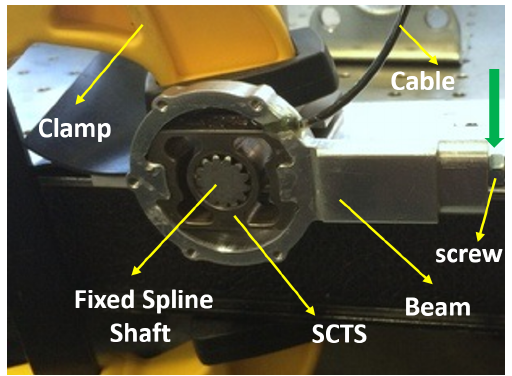
Figure 19. This experimental setup hardware mainly consists of three parts i.e., the spline shaft, the SCTS and beam. The spline shaft is fixed on the table and torque sensor inner shell is locked on it with zero-mechanical play. The beam that is locked on outer key locks of sensor and load is applied at its end in order to generate the torque. The attachment screw is used for the extension of the beam to increase its lever arm